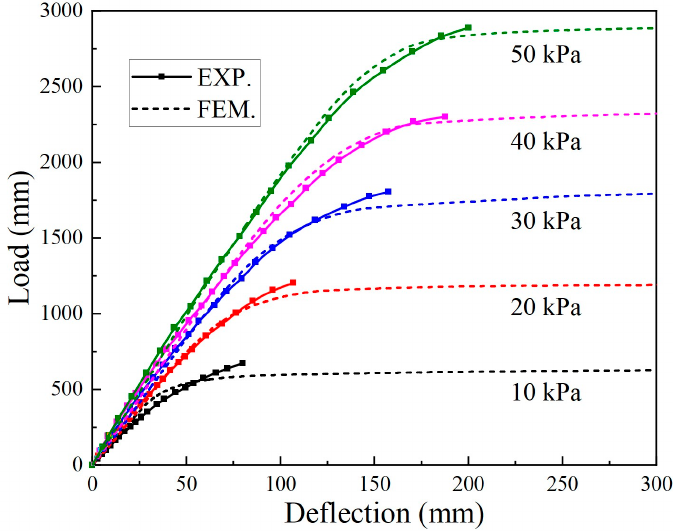
Figure 15. The local wrinkle under ultimate loading.